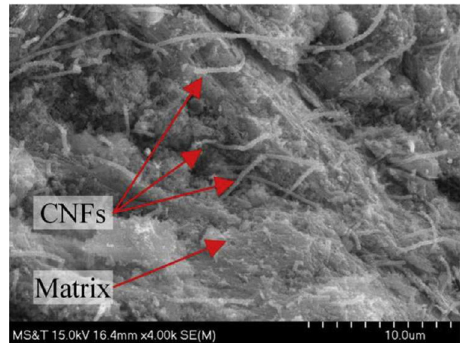
Figure 9: An SEM image of the dispersed CNFs in UHPC [ 102 ]